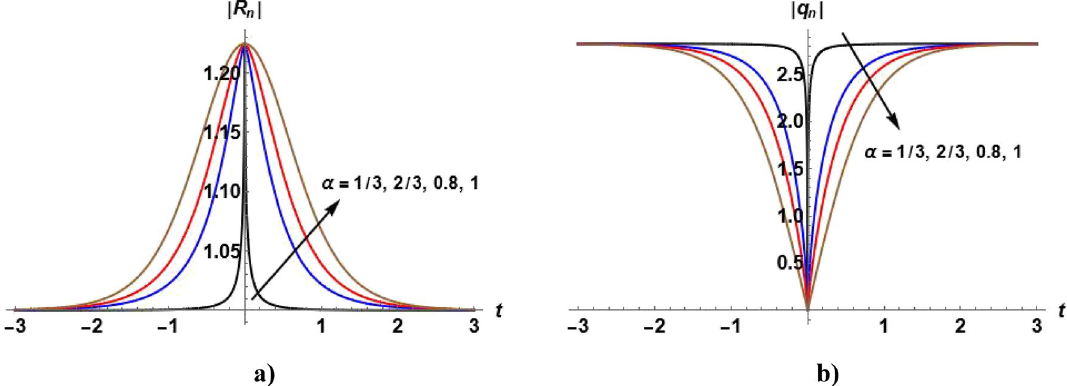
c c c c c 2 = 6 = 1, 3 = 5 = 0 , 4 = 2, β = 0.5 and odd =